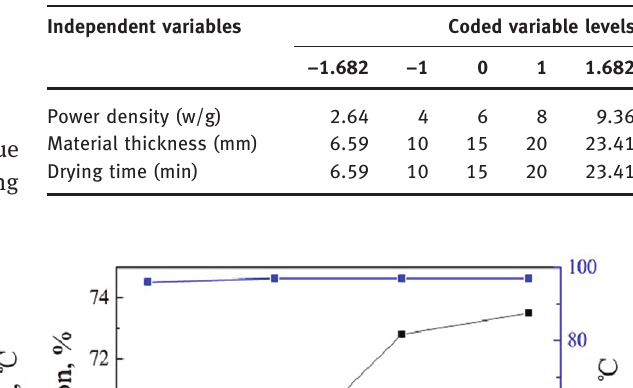
Table 1: Coded value of the independent variables and experimental